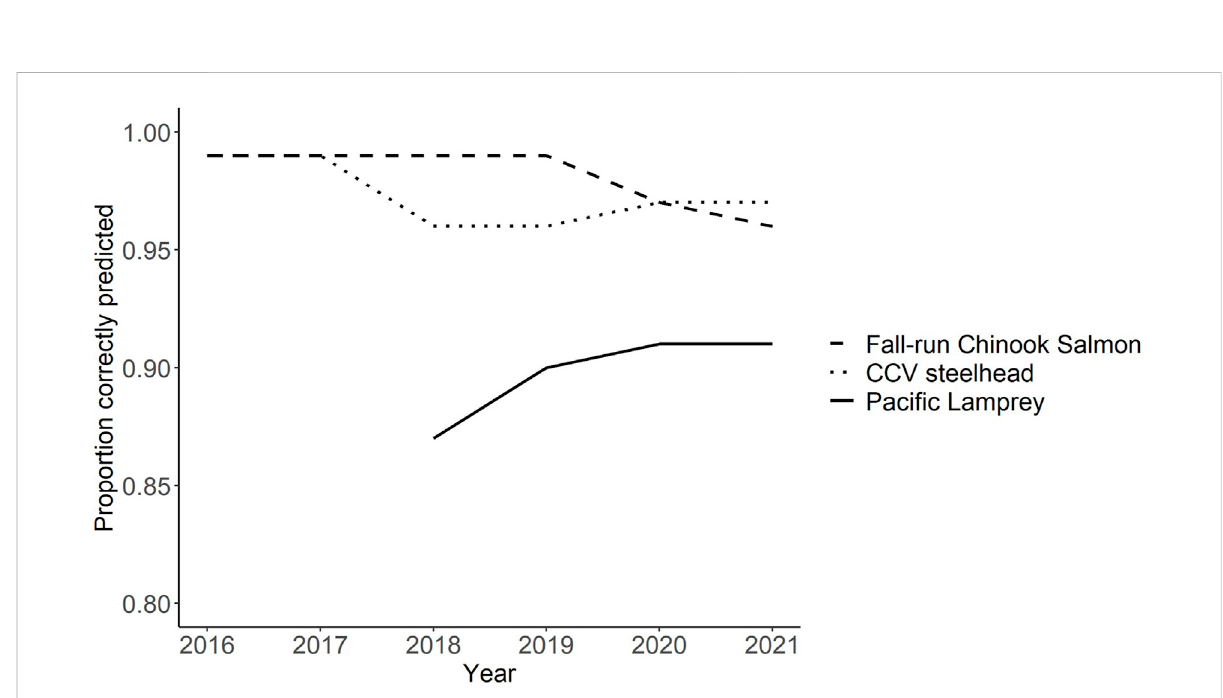
steelhead that were incorrectly predicted to be Paci fi c Lamprey had pot lengths between 50 cm and 60 cm (mean = 95 cm).